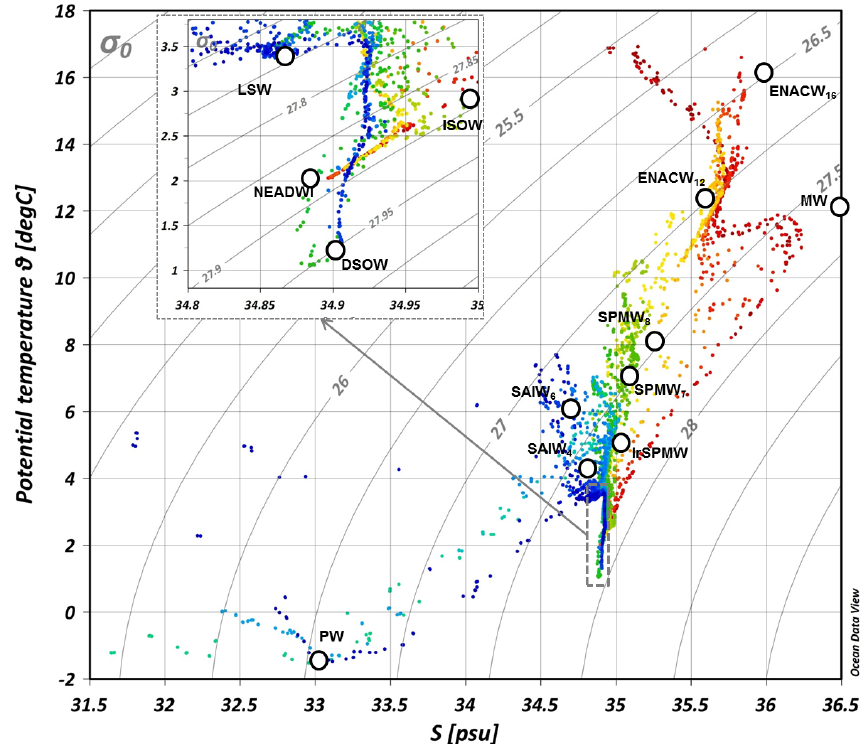
Figure 2. Potential temperature–salinity diagram – including an inset for bottom water – of the water samples (colored dots) from the GA01 section. The properties of the source-water types (based on García-Ibáñez et al., 2018) used in the optimum multiparameter (OMP) analysis are reported with white circles. Isopycnals are also plotted (potential density referenced to